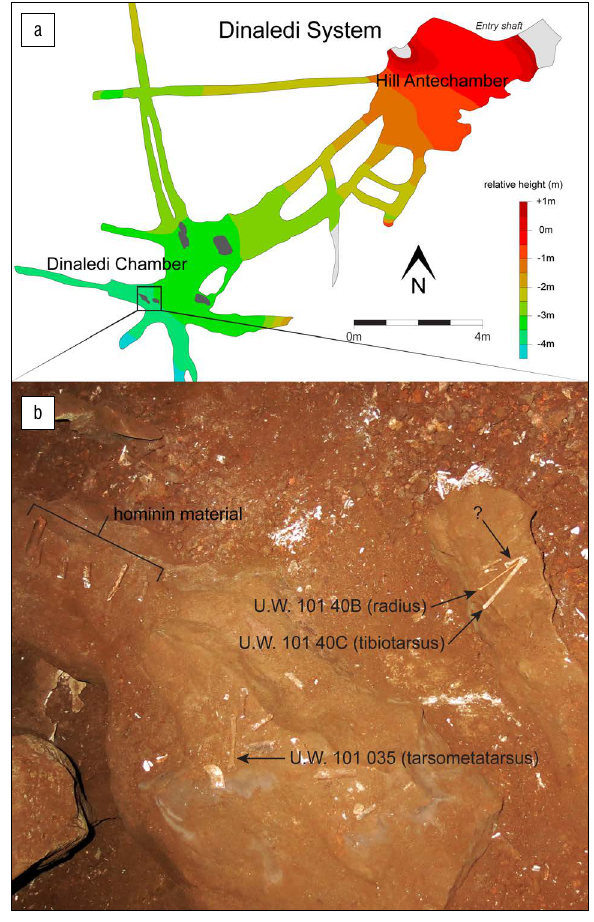
figure 5: (a) Map of the Dinaledi Chamber in the Dinaledi system, Rising Star Cave (modified after Dirks et al. 1 ); (b) location of three of the four owl remains found within the Chamber. The remains were seemingly placed on a rock, amongst other hominin material, by an unknown caver prior to investigations by the University of the Witwatersrand. An unidentifiable fragment (denoted by ?) is possibly remains of a bird, but lacks enough morphology for a proper